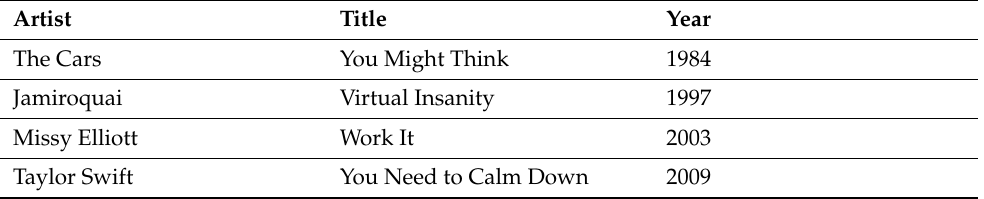
Table 2. Insect-related music videos winning the MTV Video Music Award.